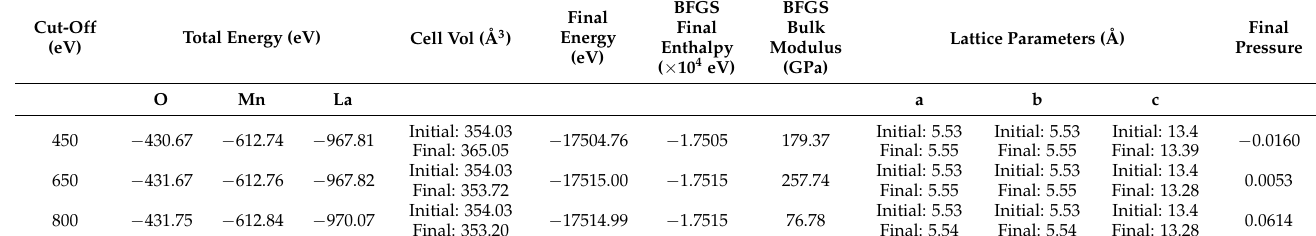
Table 7. Data of theoretical calculations using the CASTEP module with the R3c space group.